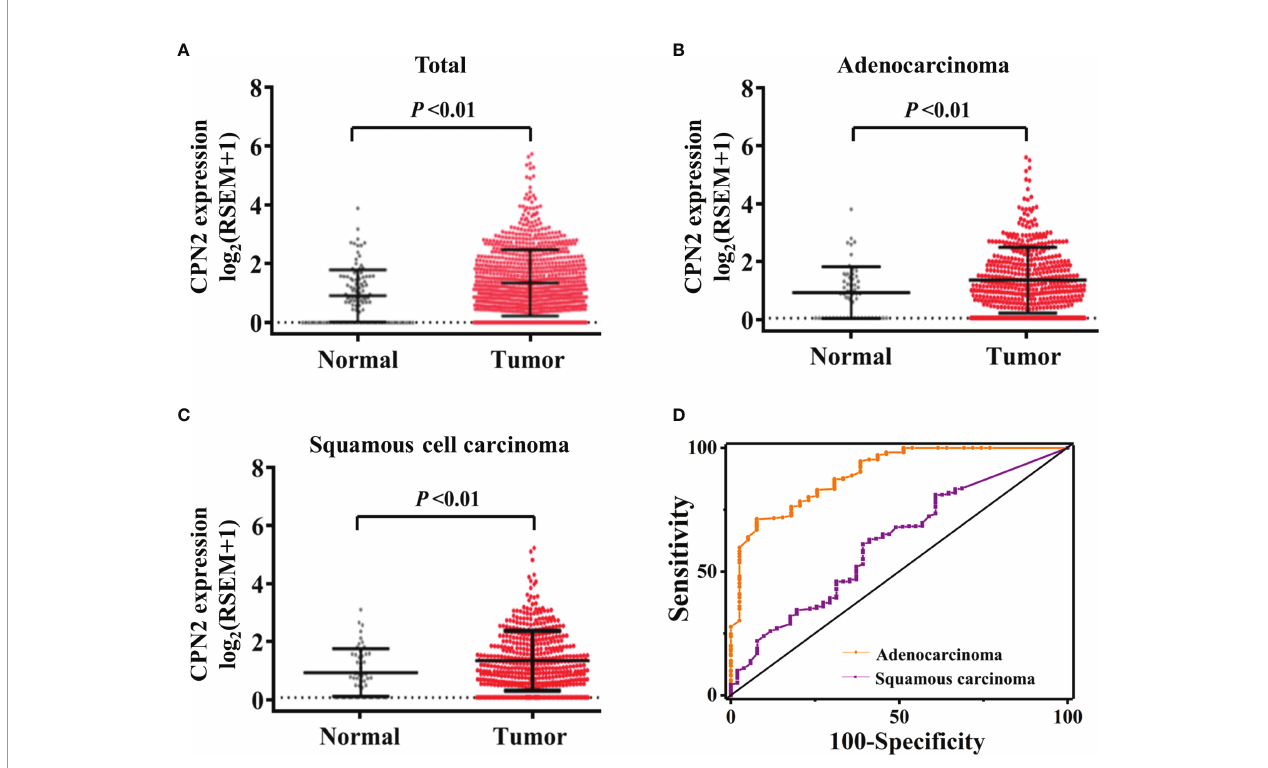
FIGURE 1 | The CPN2 transcription level was upregulated in lung cancer patients from The Cancer Genome Atlas cohort. (A) CPN2 expression was signi fi cantly upregulated in lung cancer tissues compared with the adjacent normal samples according to the total samples ( P < 0.01). Two-tailed Wilcoxon test. (B, C) CPN2 expression was signi fi cantly increased in lung adenocarcinoma (B) and squamous cell carcinoma (C) tissues compared with the adjacent normal samples ( P < 0.01). Two-tailed Wilcoxon test. (D) The receiver operating characteristic curve showed that the CPN2 gene expression level was a promising biomarker with high sensitivity and speci fi city for the clinical diagnosis of lung adenocarcinoma, but not squamous cell